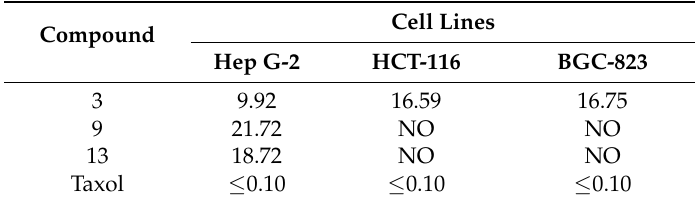
Table 2. Cytotoxicity data of compounds 3, 9 and 13 . Cell Lines Compound Hep G-2